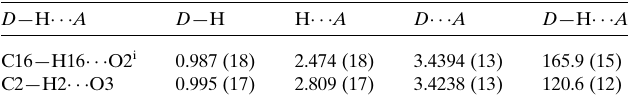
Table 4 Hydrogen-bond geometry (A˚ , (cid:3) ) for 2 .